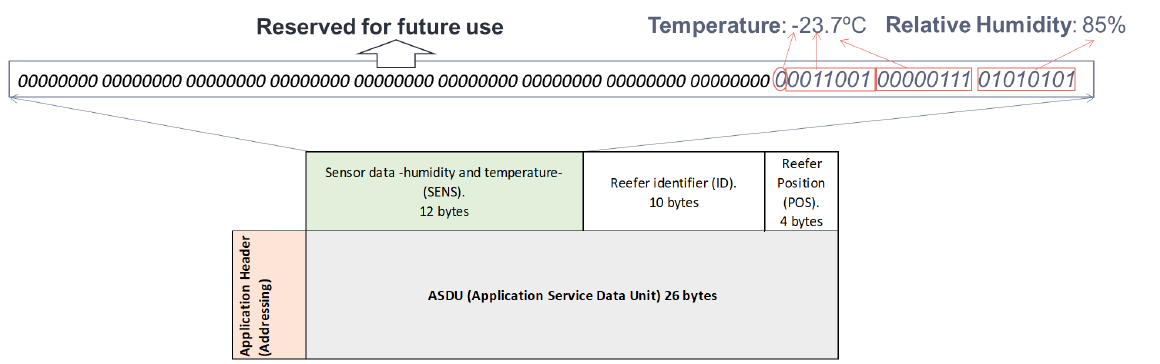
Figure 18. Detail of the message with the temperature and relative humidity of the